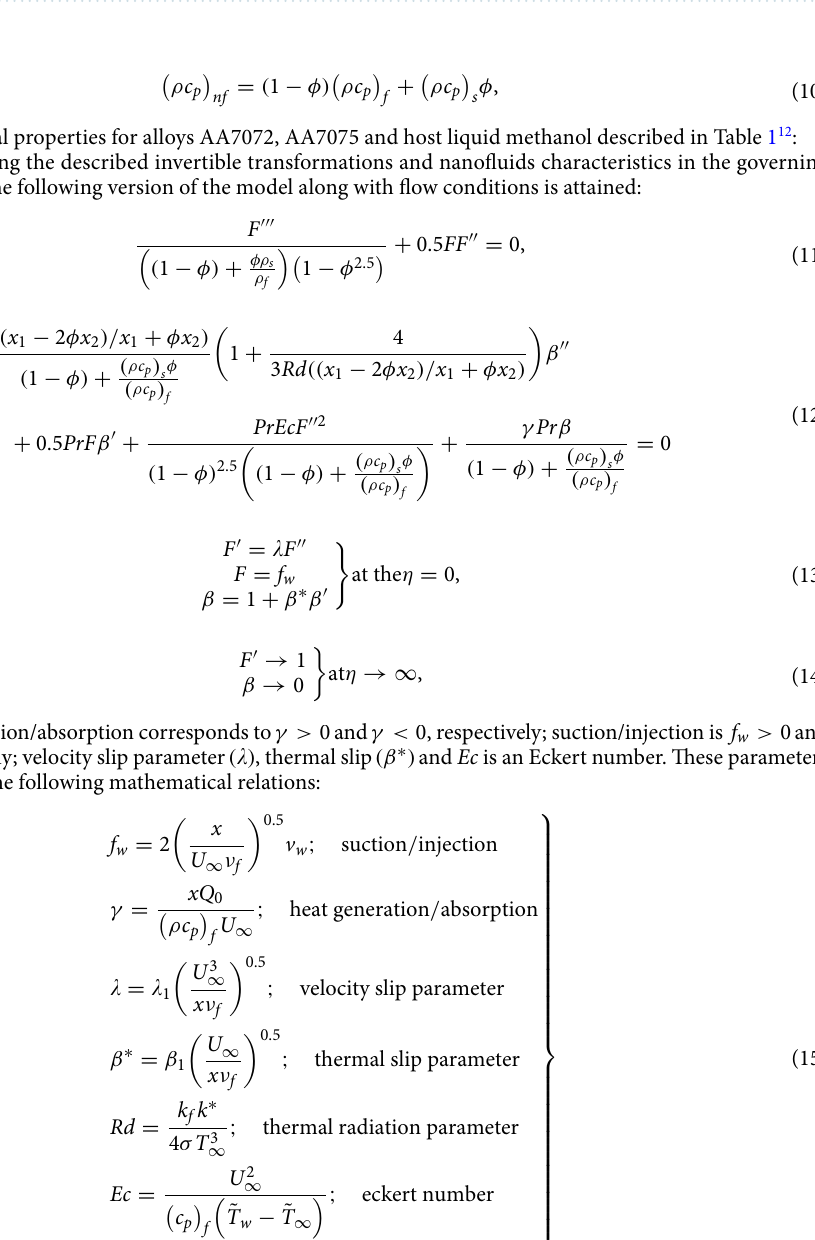
Table 1. Liquid phase and nanomaterials thermophysical